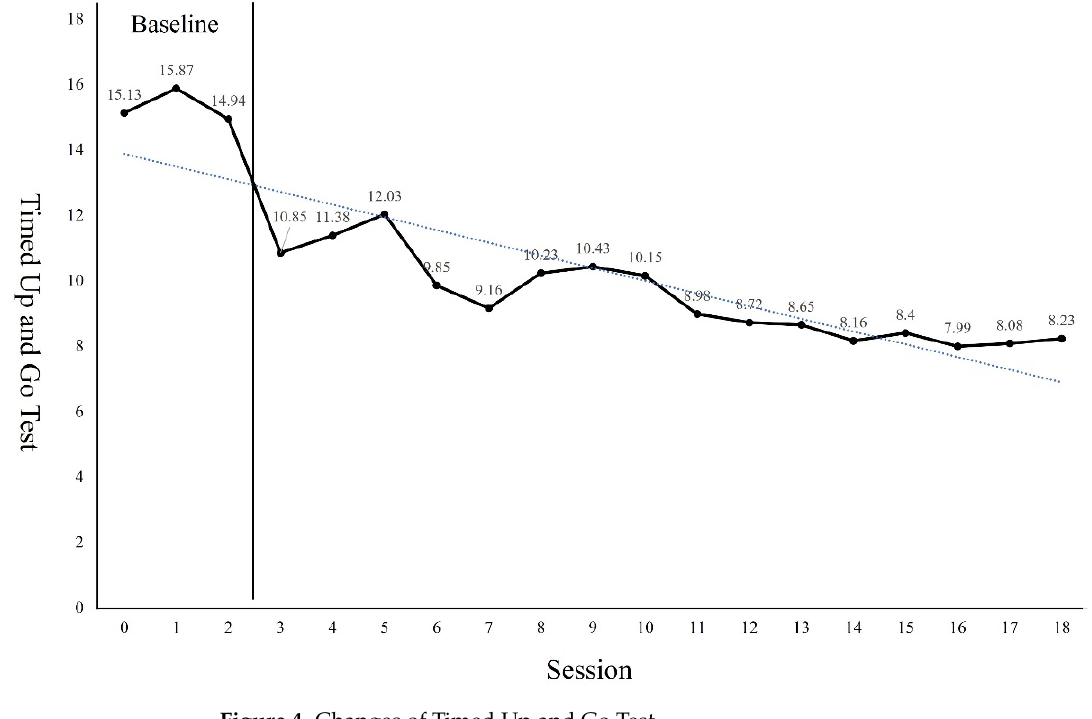
Figure 4. Changes of Timed Up and Go Test.